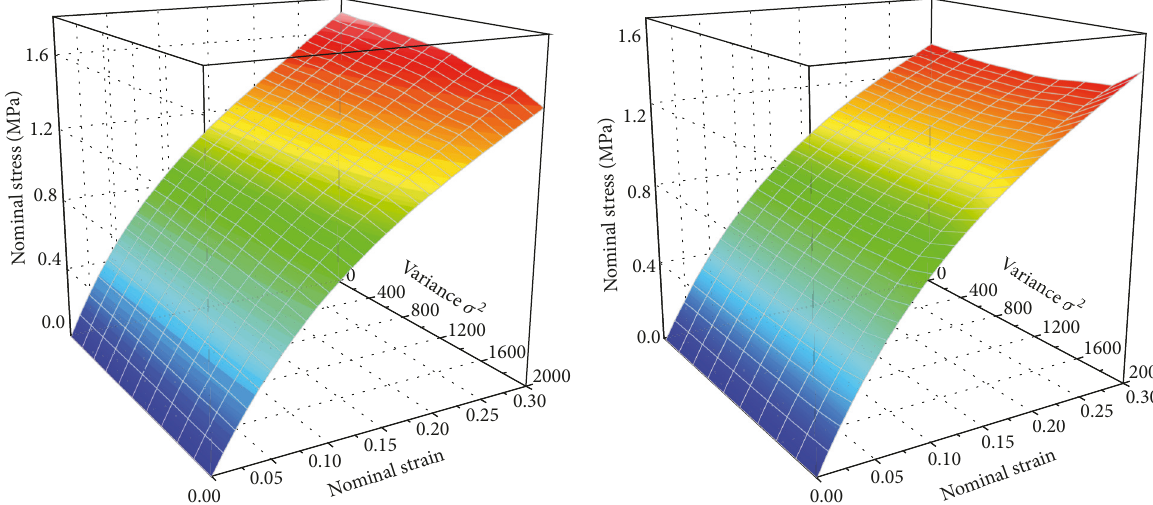
Figure 11: Response of the stress–strain of composites with different variances 𝜎 2 from the numerical results: 𝑙 f =1.5 mm, V f =0.0049.